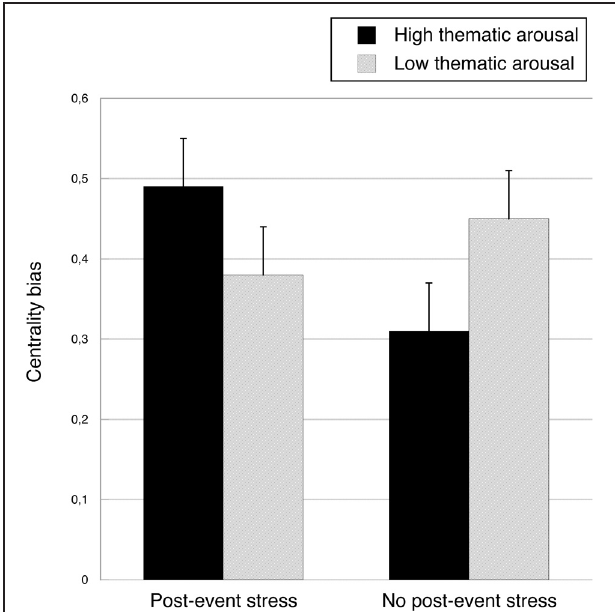
FIGURE 4 | Mean centrality bias (hit rate for central event items—hit rate for peripheral event items) as a function of post-event stress and thematic arousal, collapsed across rehearsal conditions. Bars represent standard